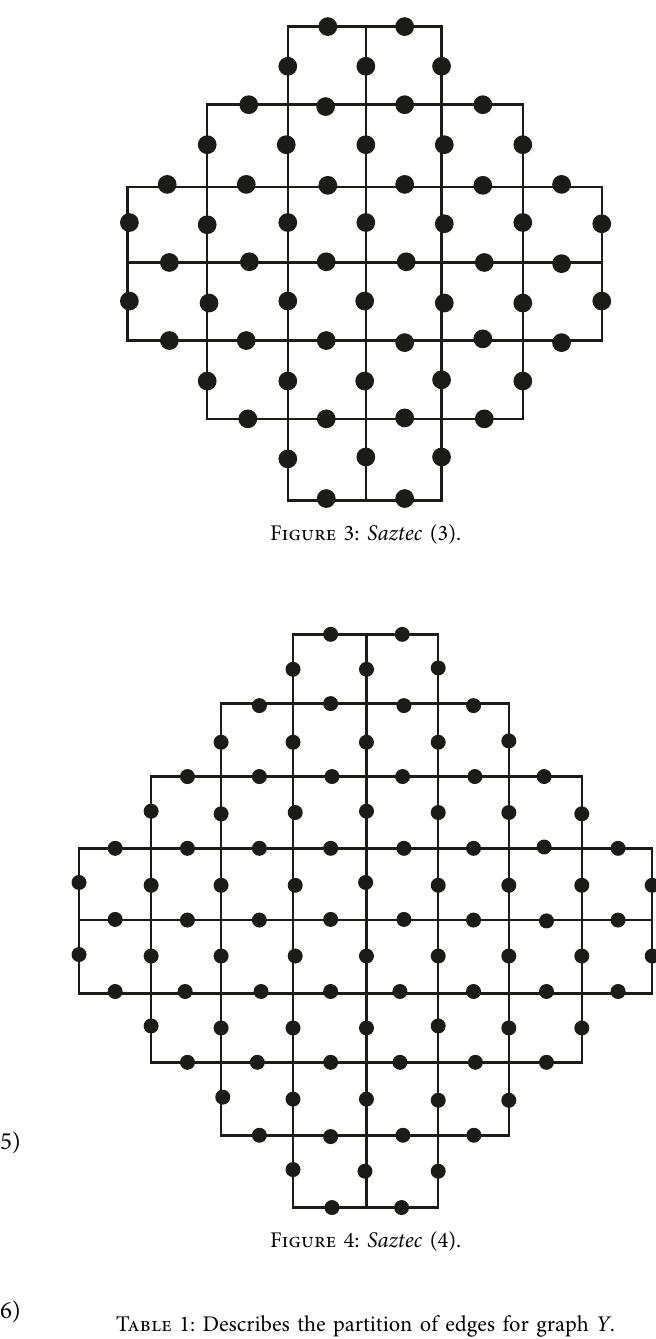
Figure 3: Saztec (3).